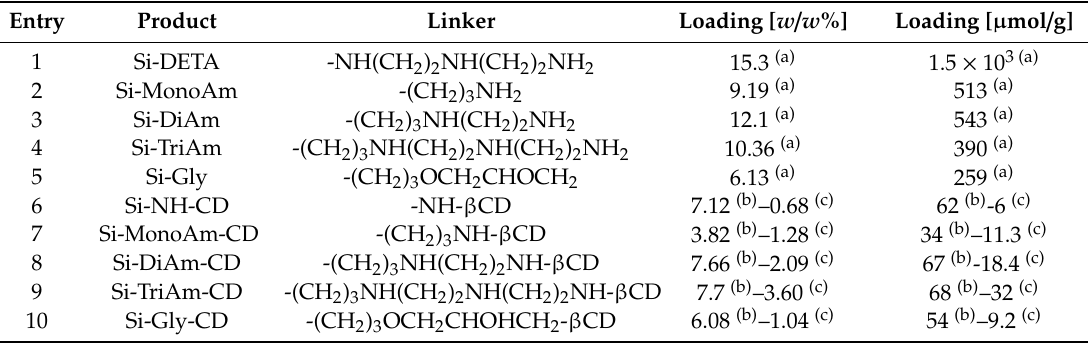
Table 1. Synthesis of grafted silica.